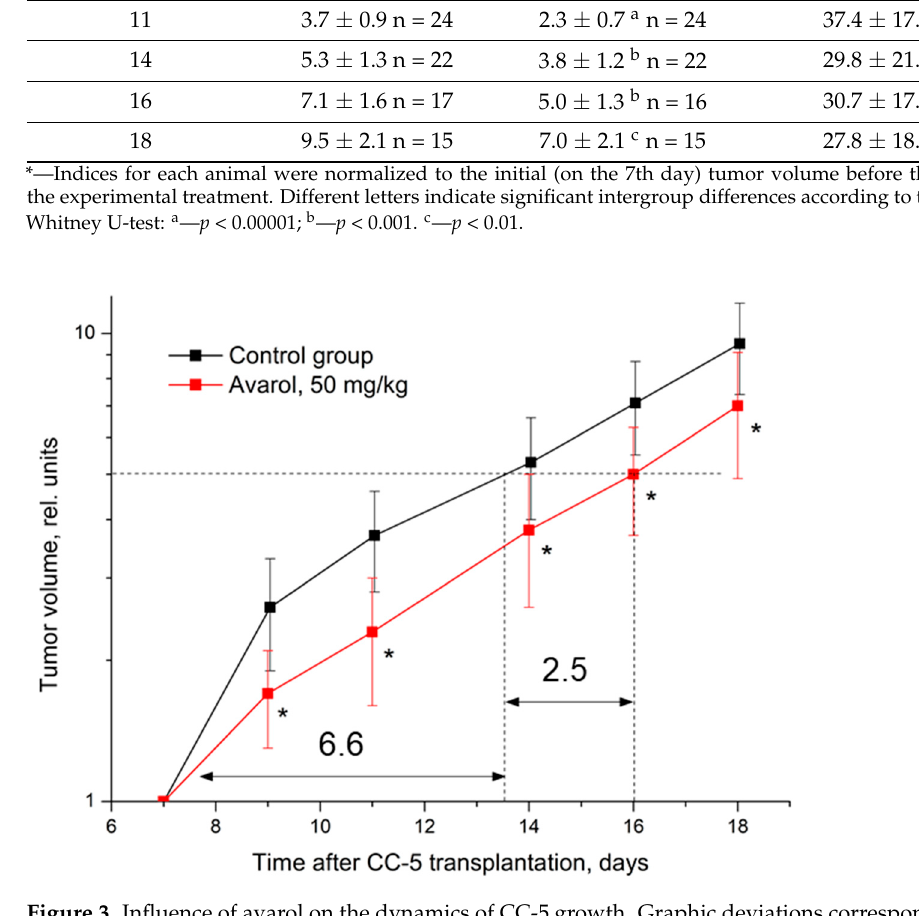
Figure 4. Influence of avarol on the masses of CC-5 tumor nodes on the 14th day (n = 5) and on the 19th day (n = 15) of observations. Panel ( A )—the appearance of tumor nodes in the experimental groups on the 19th day of growth. Panel ( B )—the distribution of the masses of tumor nodes in the experimental groups on the 14th and 19th days of growth. P —the levels of intergroup differences according to the Mann–Whitney U-test. 3. Discussion